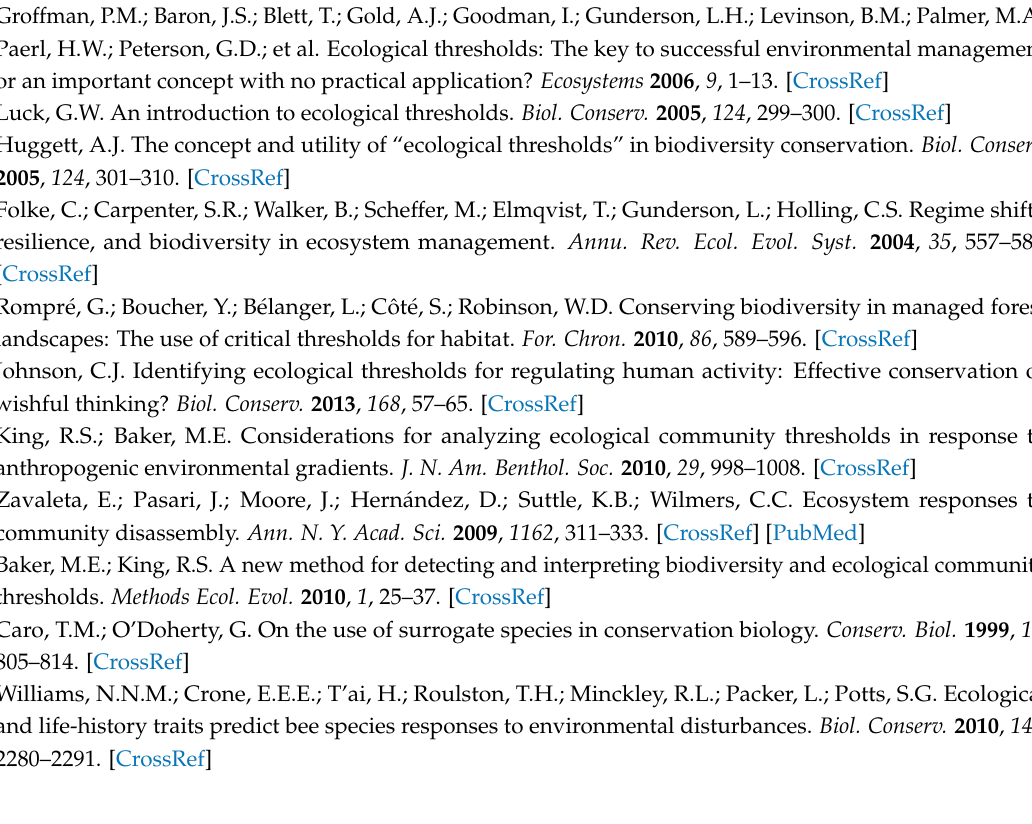
Table S1: Principal component (gradient) scores for 56 caves on Bohol Island, the Philippines included in this study, Table S2: Scientific names and ecological traits of 19 cave-roosting bat species captured on Bohol Island, Philippines, Table S3: Species-specific threshold responses to multiple environmental and human disturbance gradients on Bohol Island,